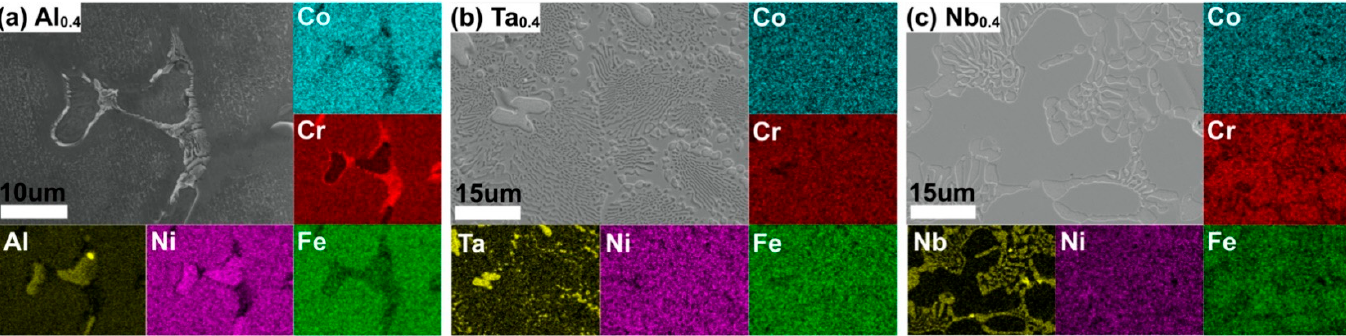
Figure 4. The EDS Mapping of the ( a ) CoCrFeNiAl 0.4 , ( b ) CoCrFeNiTa 0.4 , and ( c ) CoCrFeNiNb 0.4 HEAs prepared by PPA-AM.